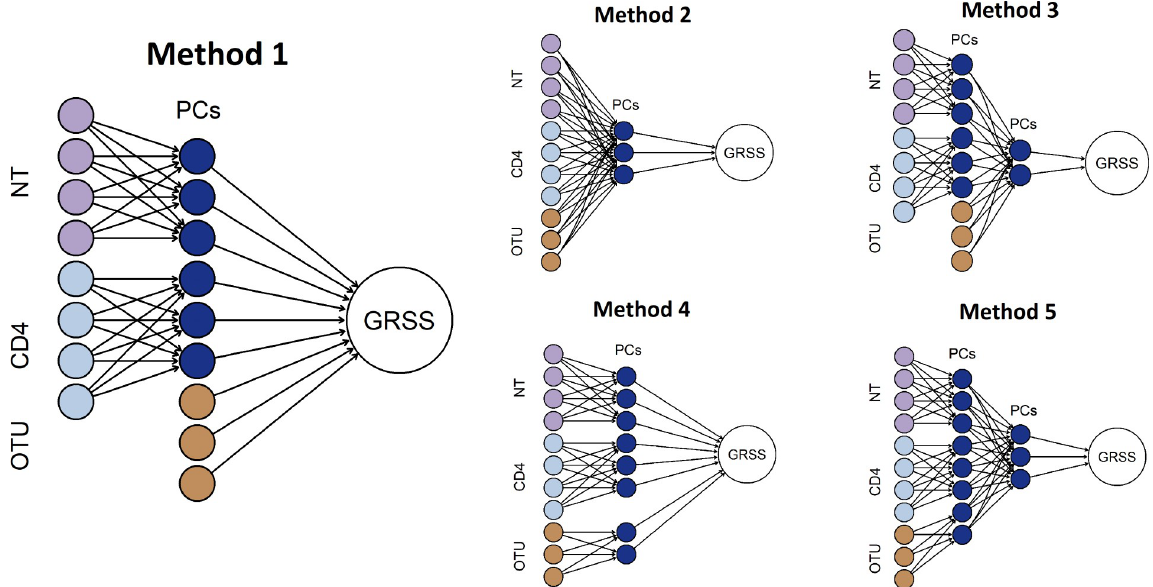
Fig 2. Five potential methods of multi-omic data integration. Methods differ in their handling of nasal microbiome data (OTU), number of levels of PCA, and the stage at which the integration occurs. Here light purple circles represent nasal gene expression profiles (NT), light blue ones represent CD4 gene expressions, and gold ones represent nasal microbiome abundance data (OTU). Dark blue ones are principal components (PCs) computed from the original features. Large white circle represents the GRSS, which is the clinical variable of interest of this study. In our assessments, the leftmost model out-performed the other models in terms of cross-validated error.